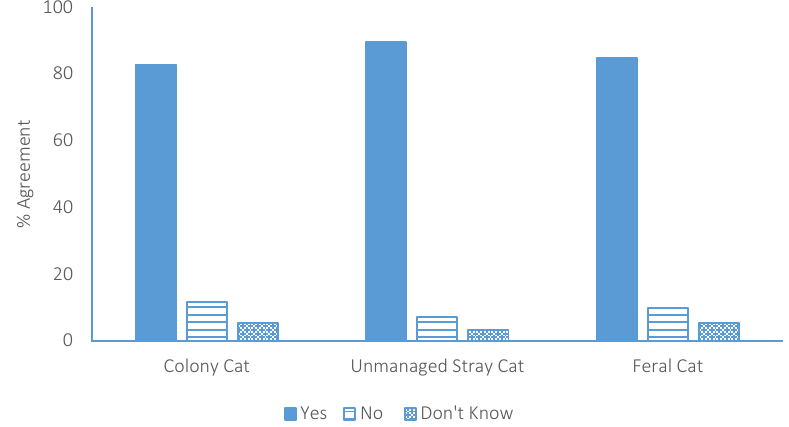
Figure 3. Participant agreement that action should be taken toward controlling each of the un-owned subgroups of cats in New Zealand.